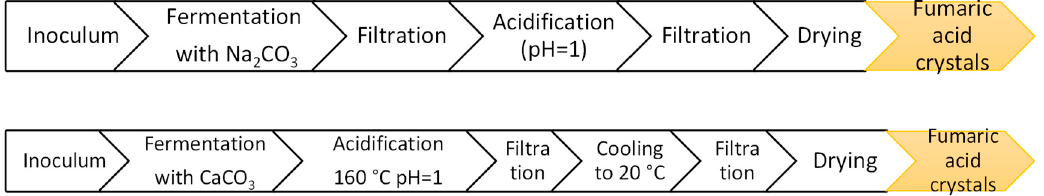
Figure 3. Pathways from glucose to fumaric acid (adapted from [31]).